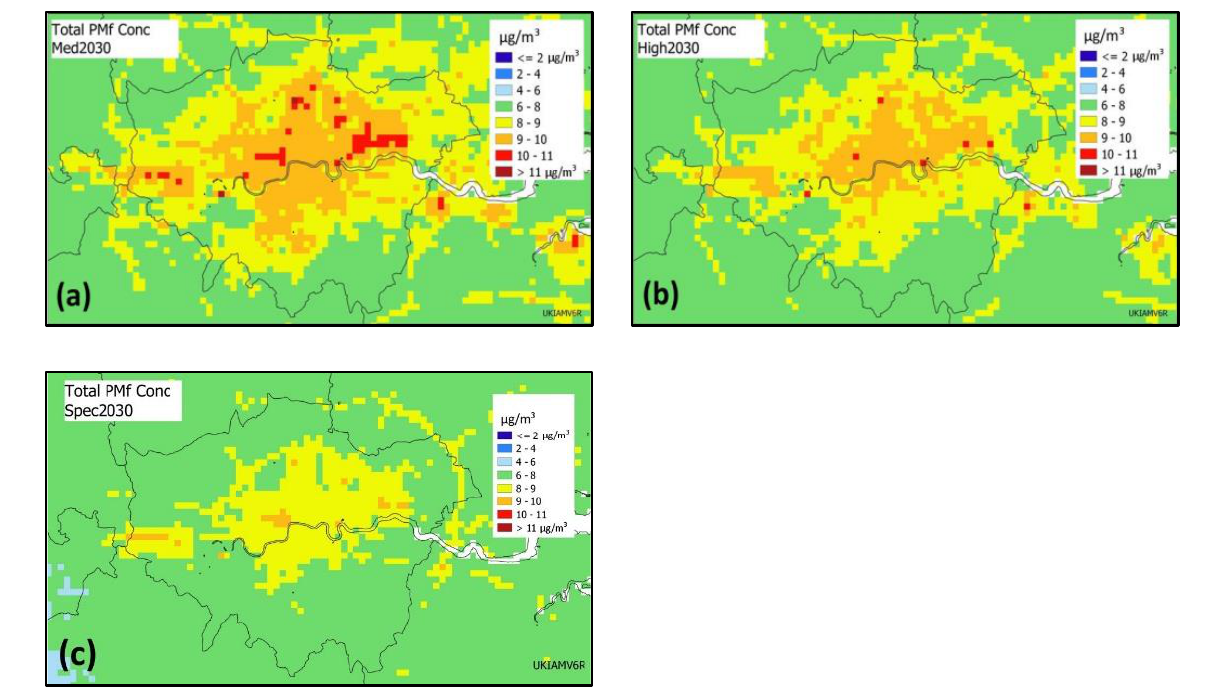
Figure 7. In 2030, there are still large areas at risk of exceeding 10 µg m − 3 , with ( a ) clear exceedance in the medium scenario, ( b ) much of central London at risk of exceedance in the high scenario, and ( c ) the speculative scenario suggests most of London would only be at risk in an adverse meteorological year.